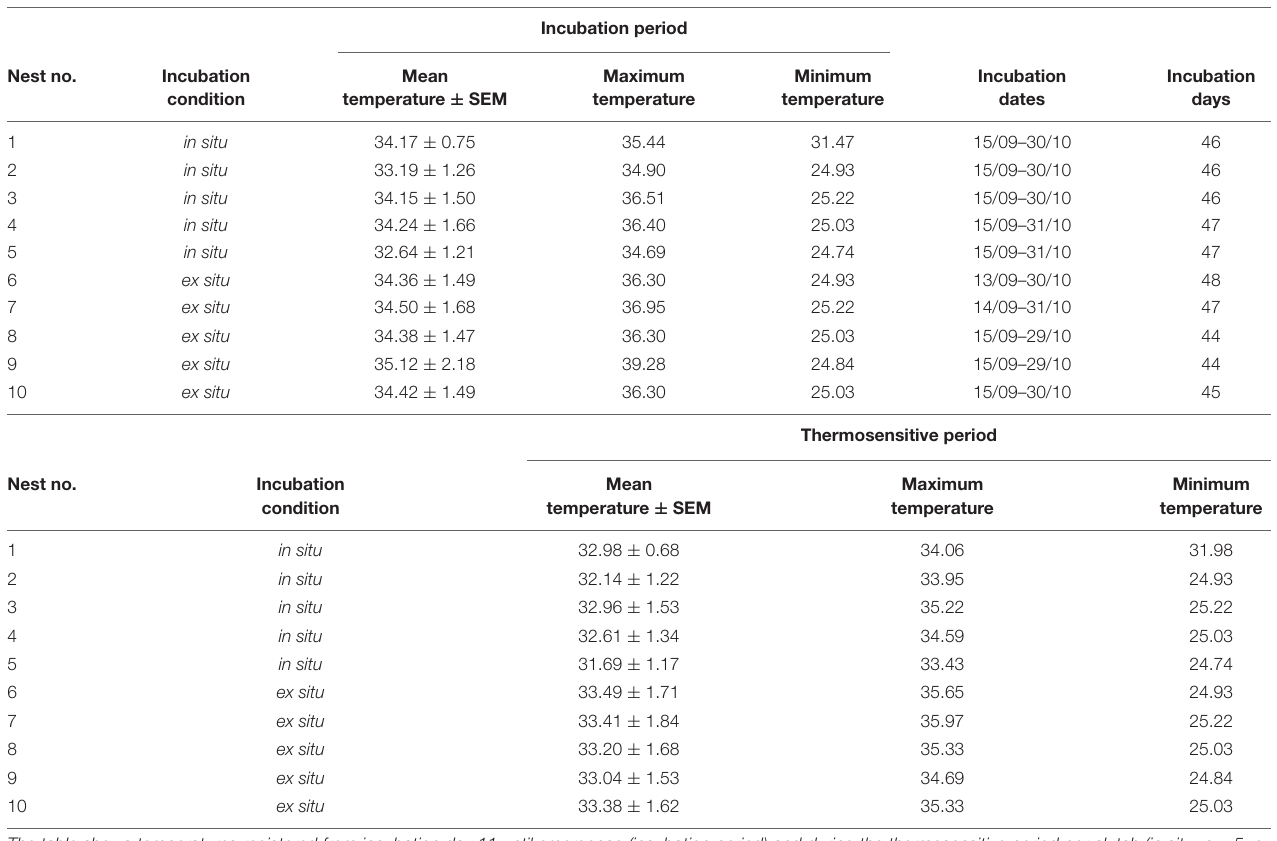
TABLE 1 | Sand temperatures ( ◦ C) monitored by data loggers located 30 cm from the center of the clutch and 50 cm deep, as well as incubation periods registered for L. olivacea hatchlings at Boca Seca beach, Lázaro Cárdenas, Michoacán, México.